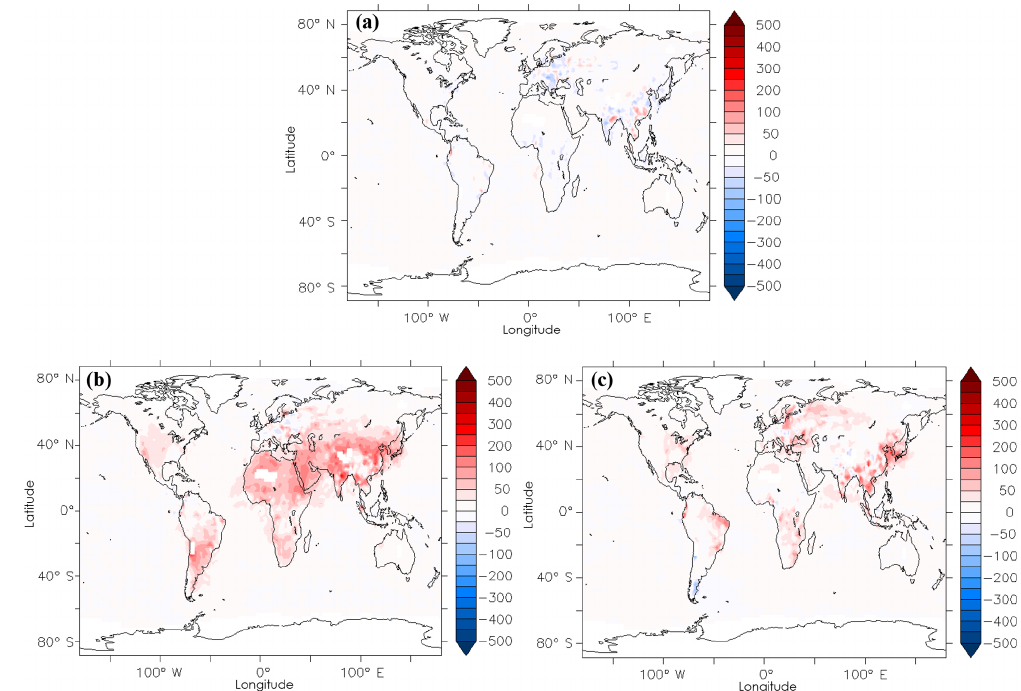
Figure 9. Absolute changes (in cm − 3 ) of the predicted annual average CDNC by (a) assuming a globally uniform chemical composition of mineral dust, (b) increasing the B FHH hydrophilicity parameter of dust by 10%, and (c) reducing mineral dust emissions by 50%. A positive change corresponds to an increase relative to the reference